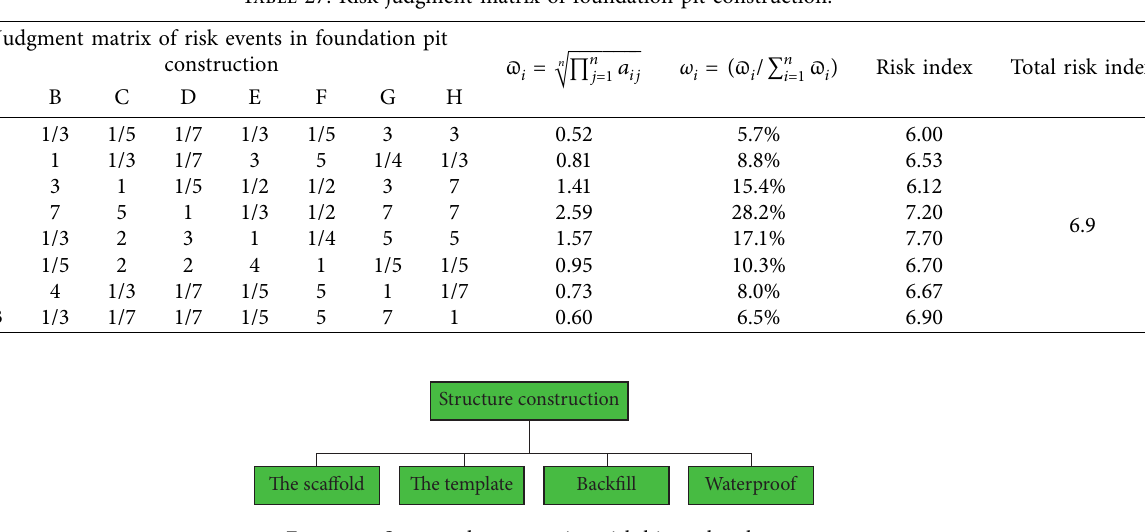
Table 27: Risk judgment matrix of foundation pit construction.